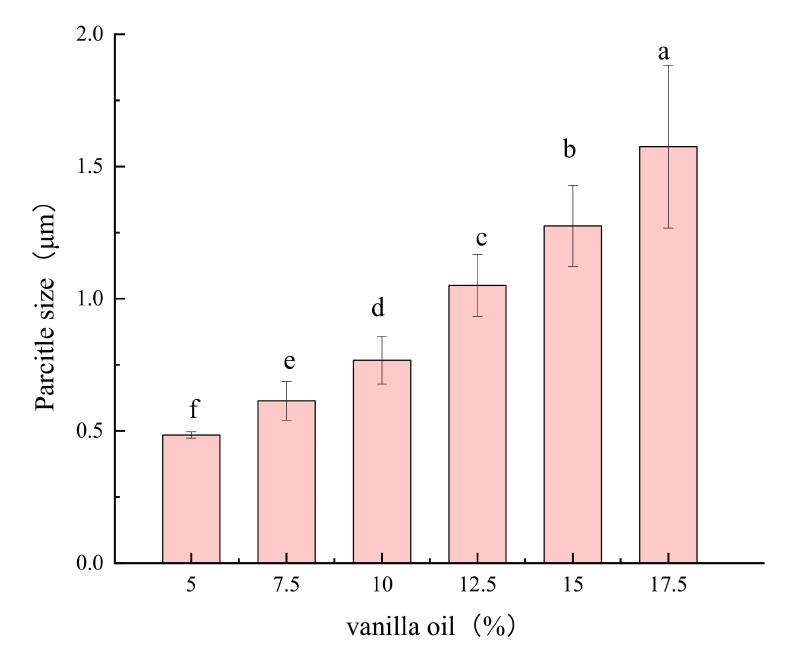
Figure 5. OSA-starch with different vanilla oil content prepared emulsion particle size. Note: Different letters represent significant differences ( p <